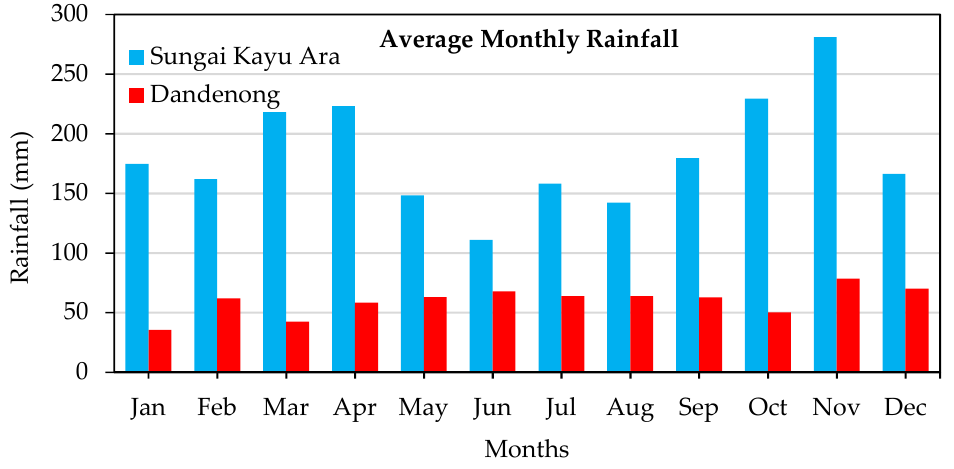
Figure 3. Average monthly rainfall in Sungai Kayu Ara and Dandenong catchments.